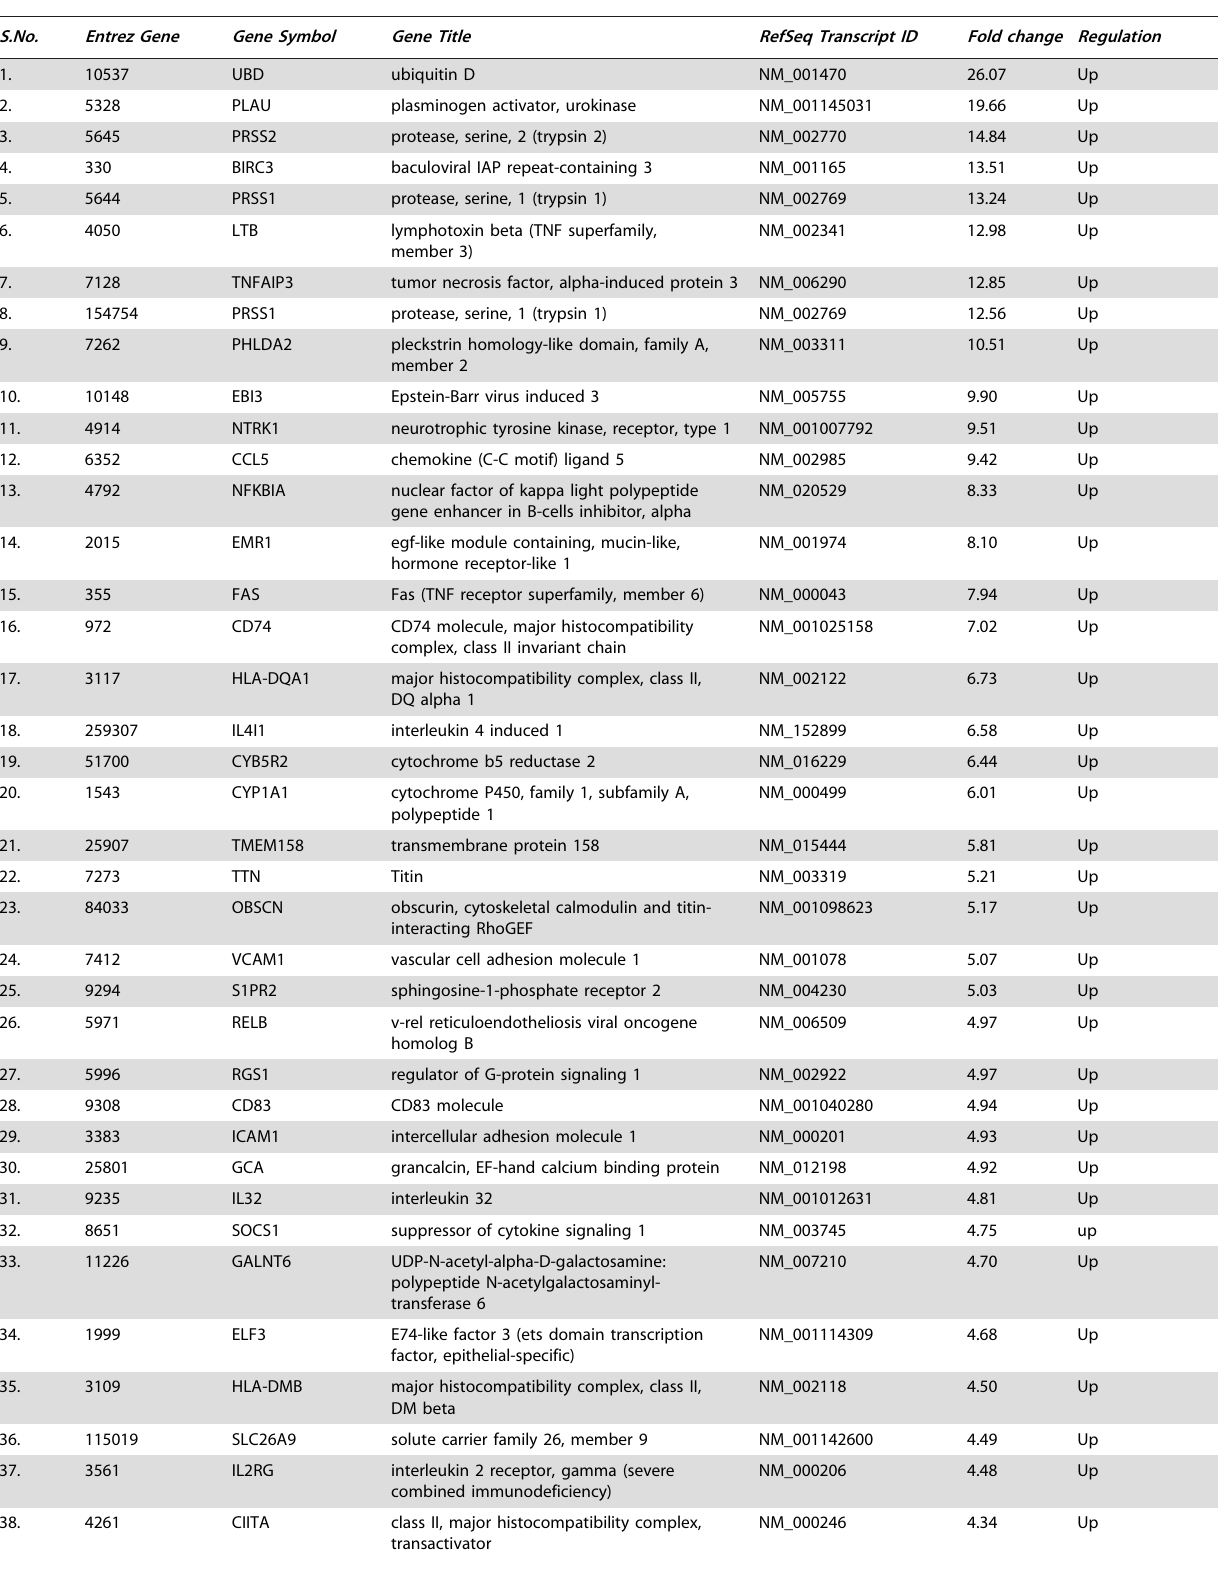
Table 1. Summary of differentially regulated gene clusters in 4OHT-treated K13-ER TAM -transduced BCBL1 cells.